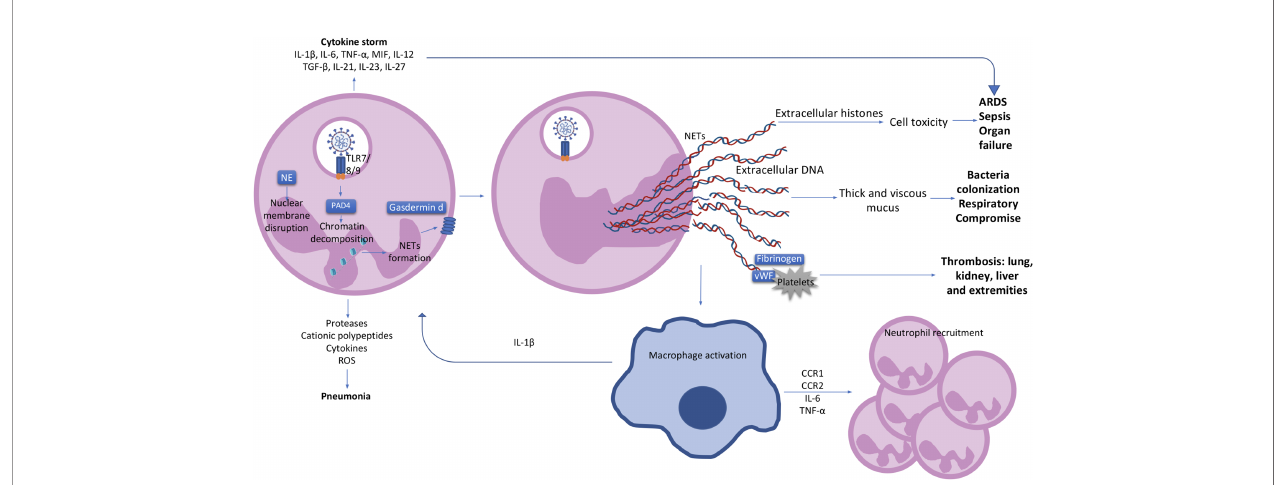
FIGURE 1 | The neutrophil and clinical characteristics of COVID-19 patients. Activated neutrophils can produce cytokines such as IL-1 b , IL-6, TNF- a , MIF, IL-12, TGF- b , IL-21, IL-23 and IL-27, contributing to a cytokine storm and the further development of ARDS and organ failure in COVID-19 patients. Pneumonia in COVID-19 patients is most likely to be caused by the production of proteases, cationic polypeptides, cytokines and ROS by neutrophils. Upon SARS-CoV-2 recognition by TLR7/8/9, protein arginase deiminase 4 (PAD4) is activated, which induces chromatin decondensation through histones citrullination and consequently NETs formation. Neutrophil nuclear membrane is disrupted by neutrophil elastase (NE) and gasdermin D which facilitates the formation of a pore in the neutrophil cell membrane and mediates release of the contents of NETs into the extracellular space. NETs induce macrophage activation and IL-1 b production resulting in a positive loop with neutrophils and NETs formation. Macrophages also secrete CCR1, CCR2, IL-6 and TNF- a leading to further neutrophil recruitment. Extracellular histones presented in NETs causes cell cytotoxicity contributing with ARDS, sepsis and organ failure observed in COVID-19 patients. Extracellular DNA induces thick and viscous mucus production allowing bacteria colonization and respiratory failure. NETs also interact with fi brinogen, VWF and platelets causing thrombosis in several organs such as lung, kidney, liver and extremities. IL, interleukin; TNF, tumour necrosis factor; MIF, macrophage migration inhibitory factor; ARDS, acute respiratory distress syndrome; ROS, reactive oxygen species; PAD4, protein arginase deiminase 4; NETs, neutrophil extracellular trap; NE, neutrophil elastase; CCR, chemokine receptor; DNA, deoxyribonucleic acid; VWF, von Willebrand